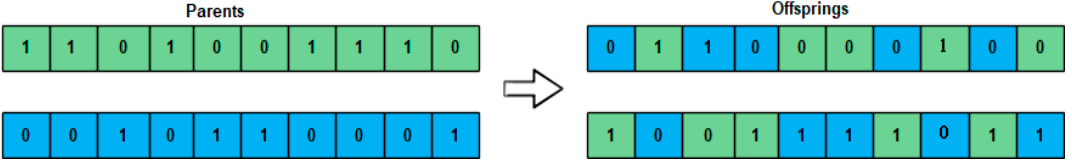
Figure 4. Uniform crossover.